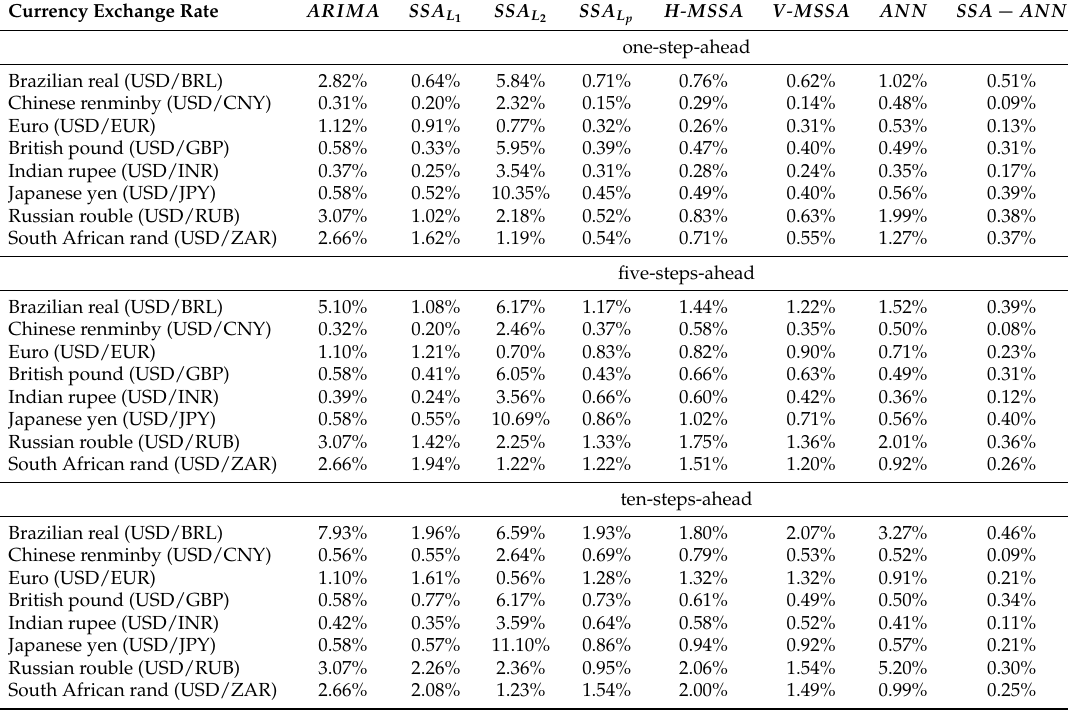
Table 8. Mean absolute percentage error for model forecasting for each of the eight currency exchange rates, considering each of the eight models/algorithms, ARIMA, SSA for the window length and number of eigentriples for reconstruction as defined in Table 3, multivariate SSA for the window length and number of eigentriples for reconstruction as defined in Table 3, ANN, and the hybrid method that combines SSA and ANN.